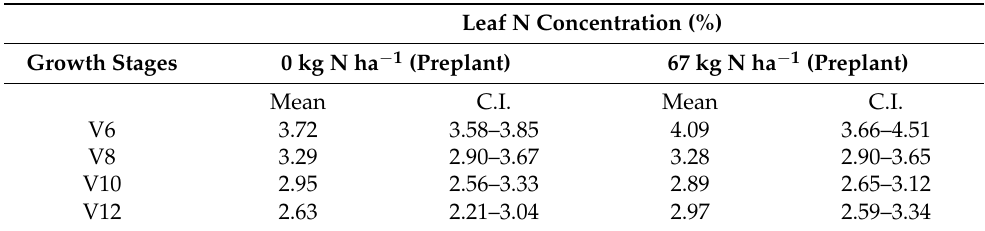
Table 7. Mean and confidence intervals (C.I.) of leaf N concentration at early corn growth stages (V6, V8, V10, and V12) using two preplant N doses (0 and 67 kg ha − 1